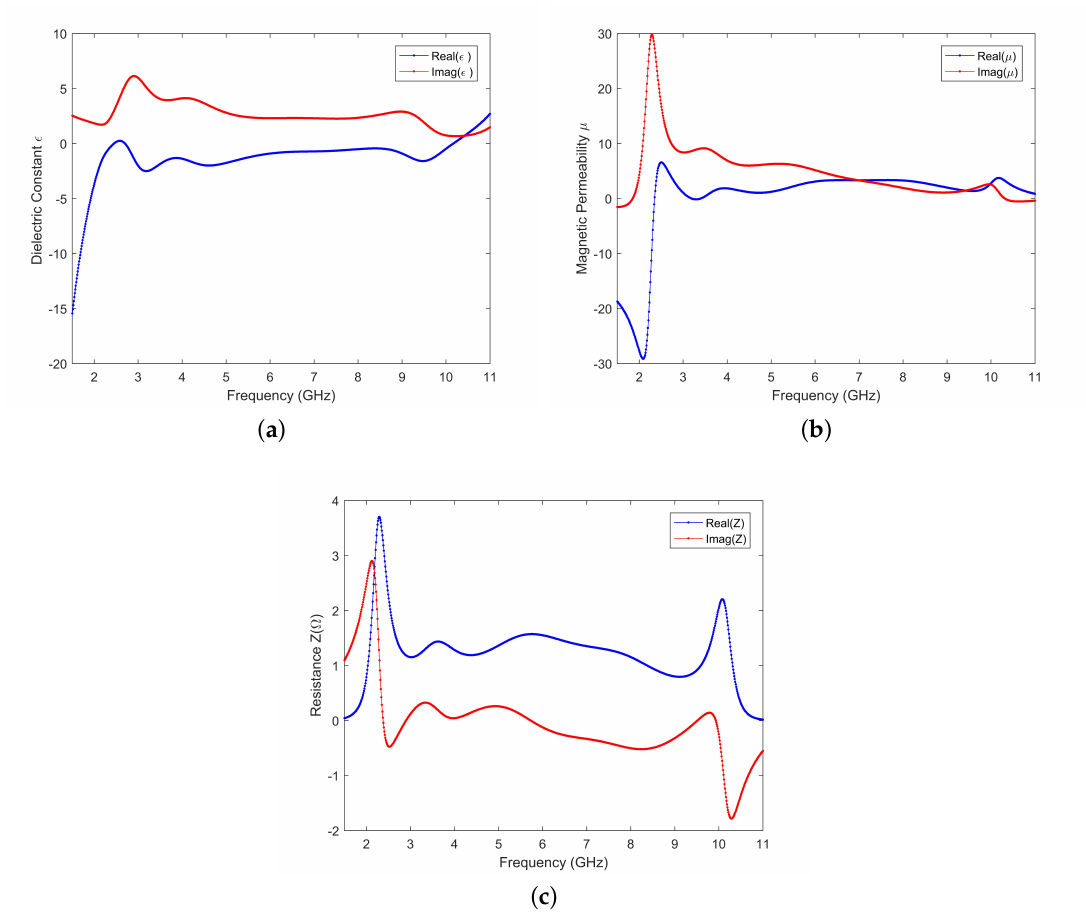
Figure 4. ( a ) Equivalent dielectric constant. ( b ) Equivalent permeability. ( c ) Relative resistance calculated by electromagnetic